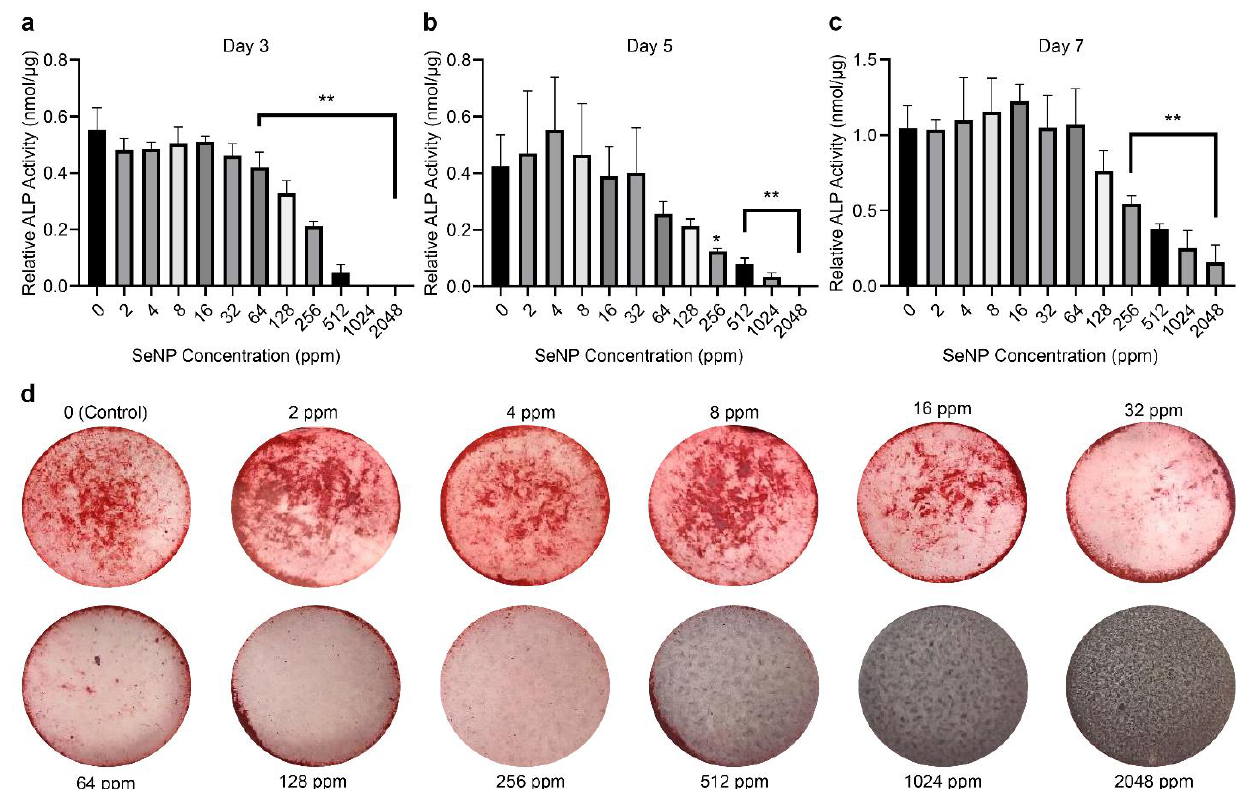
Figure 3. Effect of selenium nanoparticles (SeNPs) on relative alkaline phosphatase (ALP) activity on ( a ) day 3 ( b ) day 5, and ( c ) day 7. Relative ALP activity was calculated based on ALP and bicinchoninic acid assays. ( d ) Alizarin red staining after 21 days. Samples with SeNP concentrations of 2–16 ppm showed calcification comparable with the control, whereas those with SeNP concentrations of 32 ppm and above showed zero to low levels of calcification. Data are expressed as mean ± standard deviation, n = 4. (*: p < 0.05, **: p < 0.01).